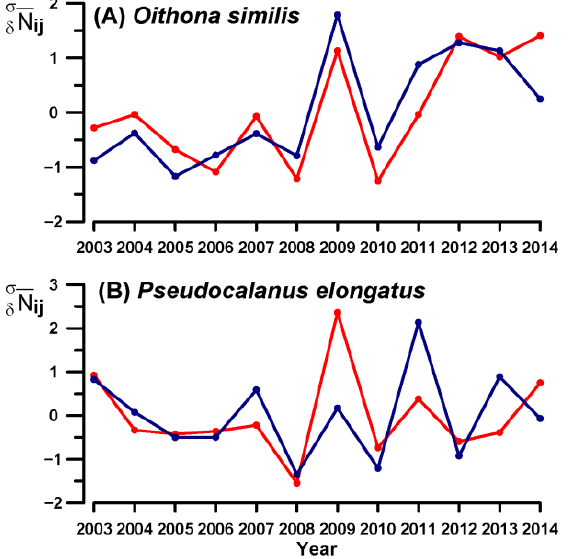
Figure 11. Pattern of interannual variability of abundance of cold-water crustaceans in Sevastopol Bay at station 1 (blue) and station 2 (red) presented as normalized annual anomalies (see details of the method in Section 2.4): ( A ) — Oithona similis ; ( B ) — Pseudocalanus elongatus .